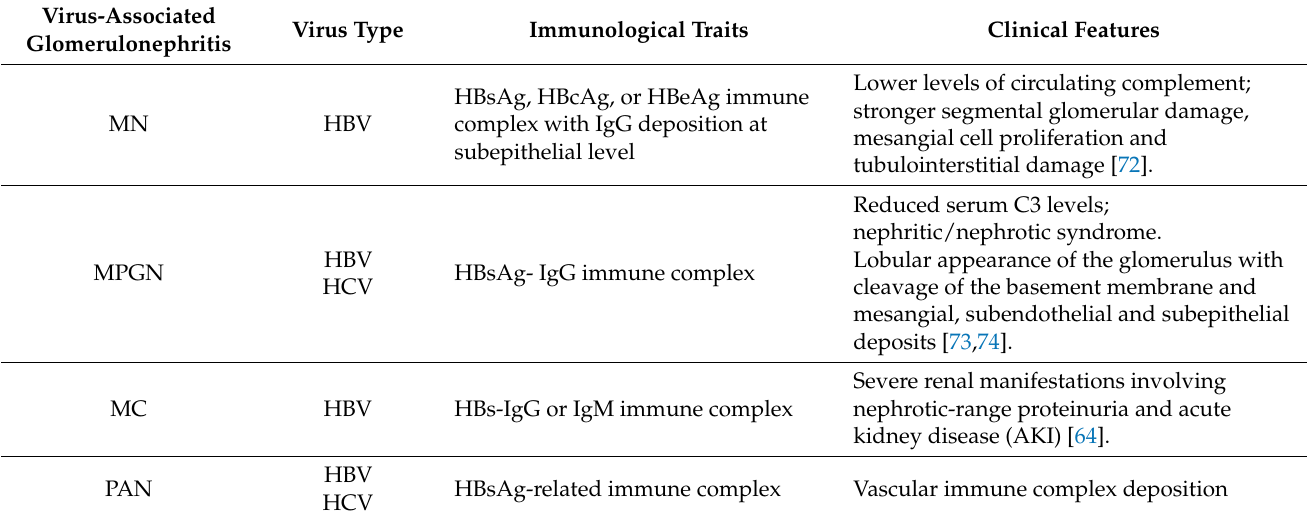
Table 1. Main features of HBV and HCV- associated Glomerulonephritis. Virus-Associated